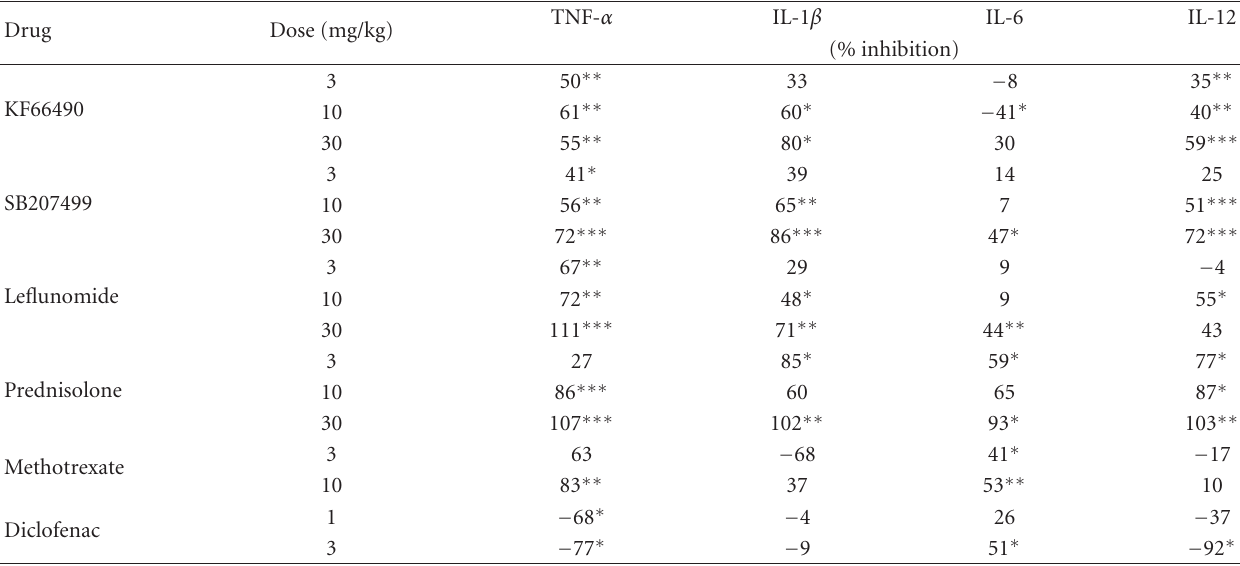
Table 1: Summary of cytokine productions.